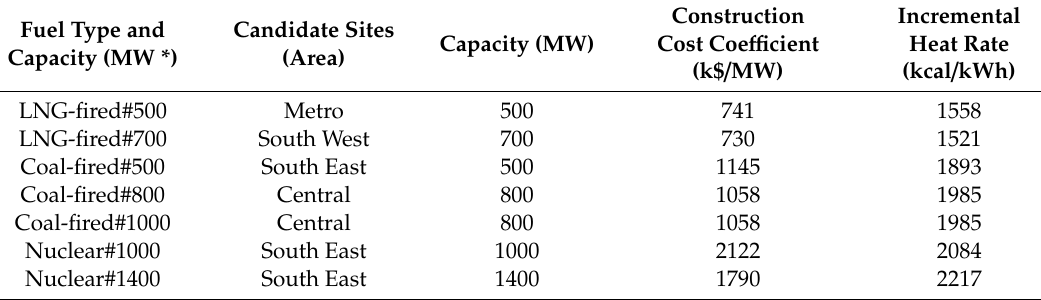
Table 1. Data for Candidate Generation Unit.